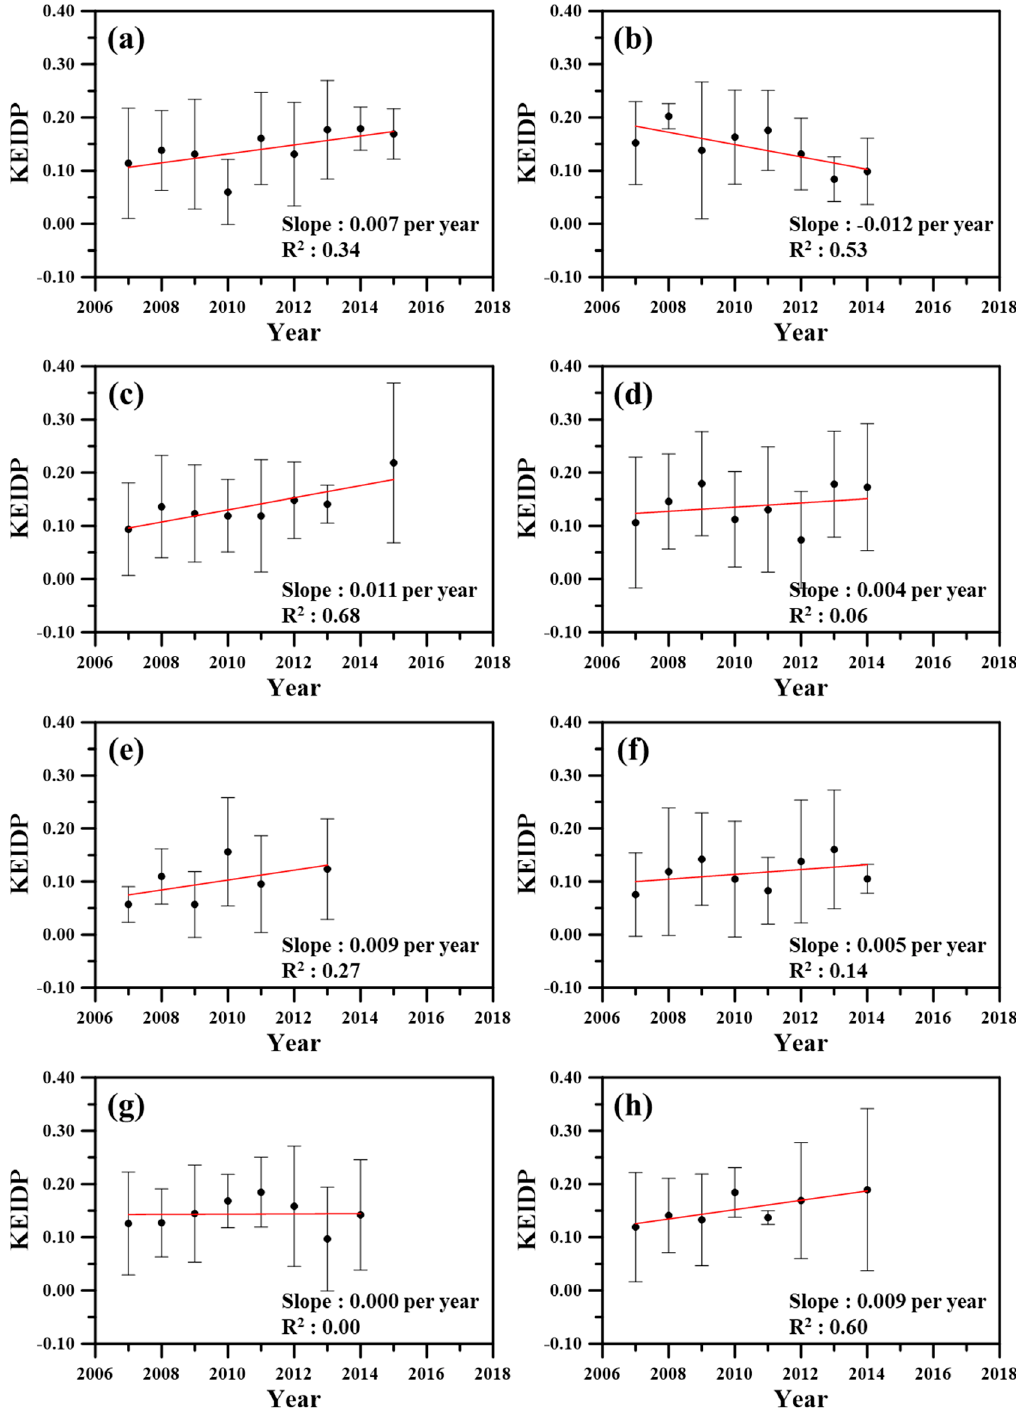
Figure 6. Development projects trends by EIA agency: ( a ) direct management by the Ministry of Environment; ( b ) Daegu Province Environmental Agency; ( c ) Han River Basin Environmental Agency; ( d ) Geumgang Basin Environmental Agency; ( e ) Jeonbuk Province Environmental Agency; ( f ) Nakdong River Basin Environmental Agency; ( g ) Wonju Province Environmental Agency; ( h ) Yeongsan River Basin Environmental Agency.